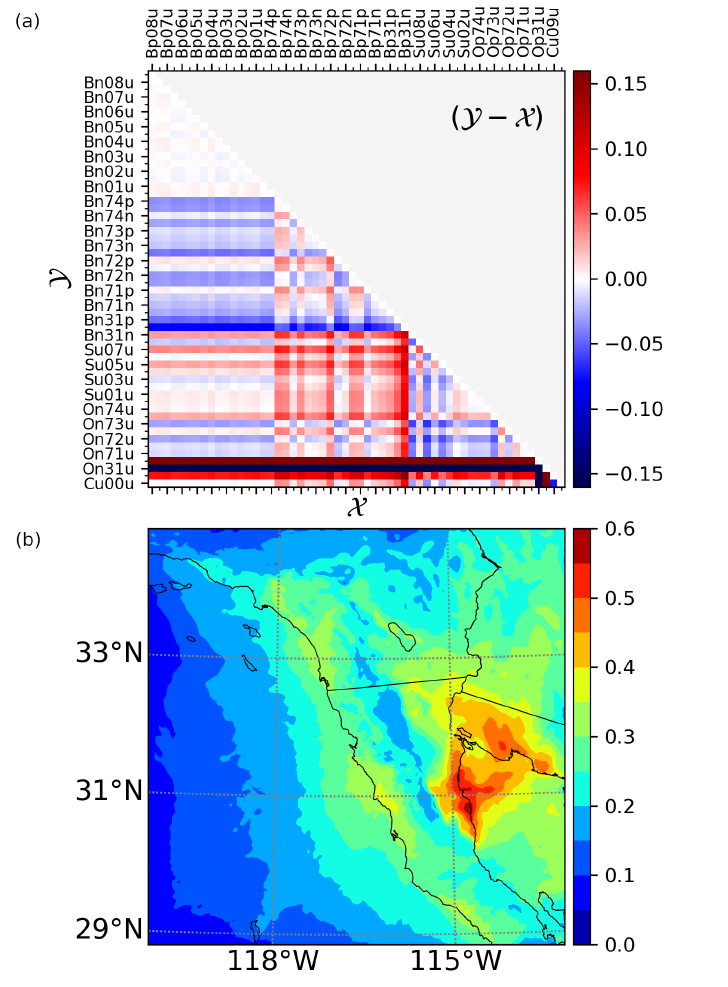
Figure 10. Overall bias ( a ) and standard deviation ( b ) of all members for water vapor mixing ratio in g/kg. Valid for the simulation period starting at 00Z on 27 February